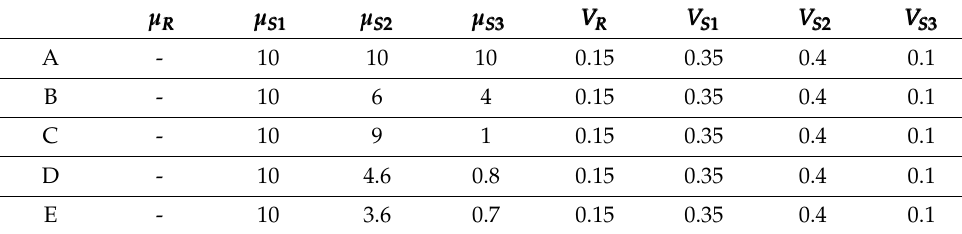
Table 6. Distribution types of the random variables.